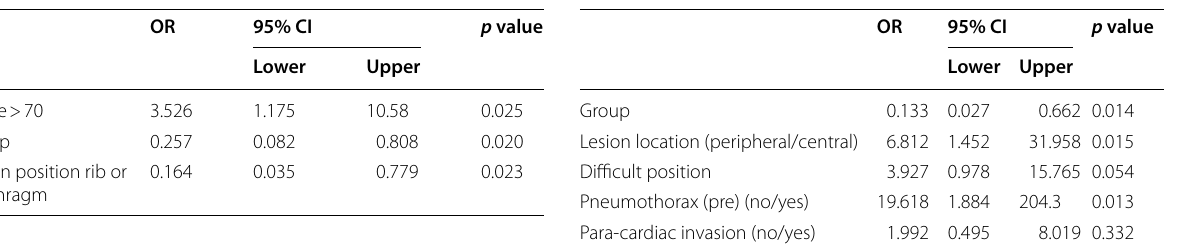
Table 6 Multivariate analysis of the risk factors related